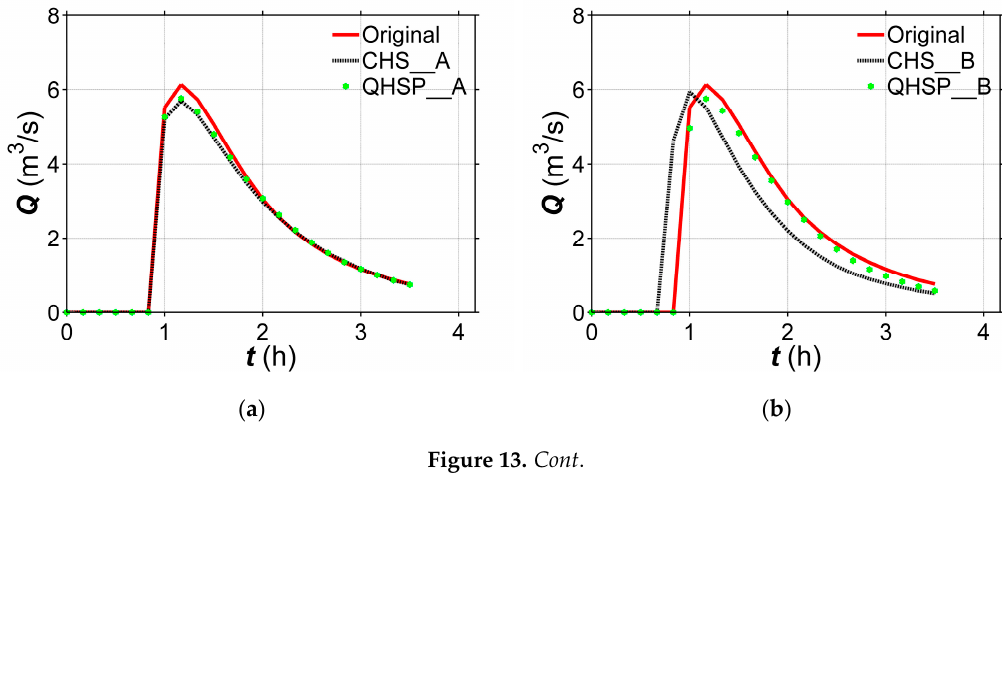
( d ) Figure 13. Computed hydrograph for test case and ( d ) D at Section 3 in the constructed river with the amplitude of 600 m. ( a ) case A; ( b ) B, ( c ) C. Table 2. Mean Error ( ME ) and Root Mean Square Error ( RMSE ) of the computed hydrograph on the constructed river bed by CHS and QHSP method. Test cases